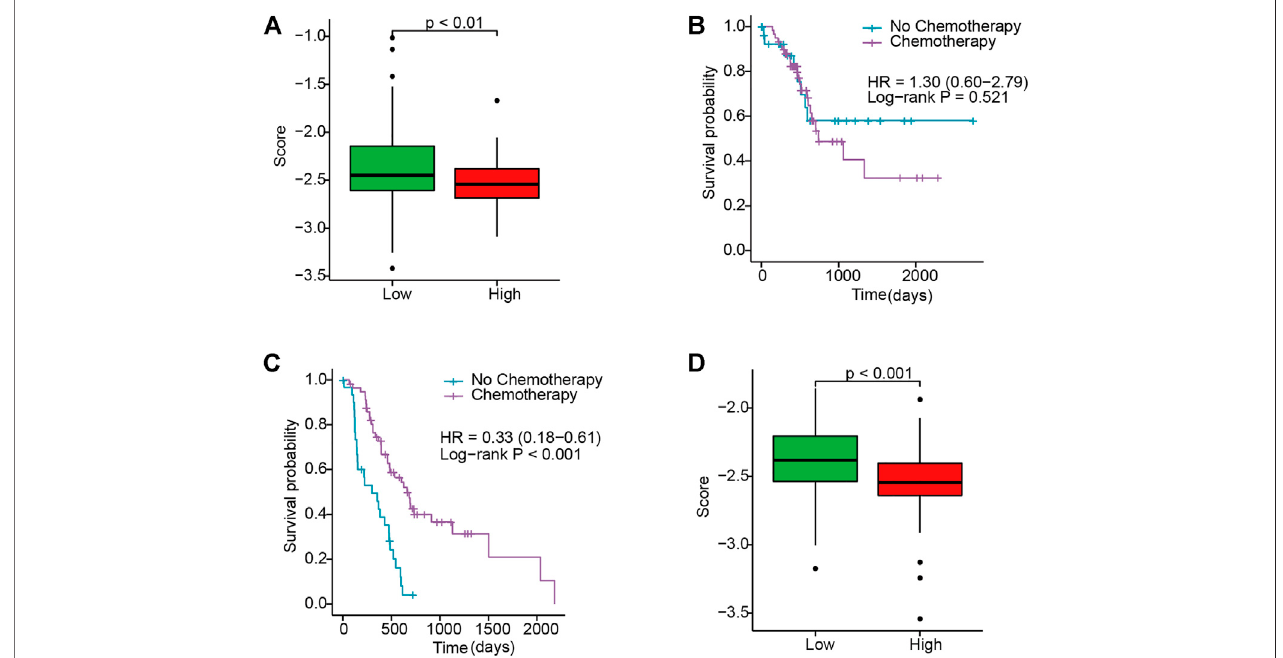
FIGURE5| Evaluatingtheresponsetogemcitabinebetweenhigh-andlow-riskpatients. (A) BoxplotoftheIC50inTCGA. (B,C) KMcurvesforchemotherapyuse subgroups in low- and high-risk patients in TCGA, respectively. (D) Box plot of the IC50 in E-MTAB.